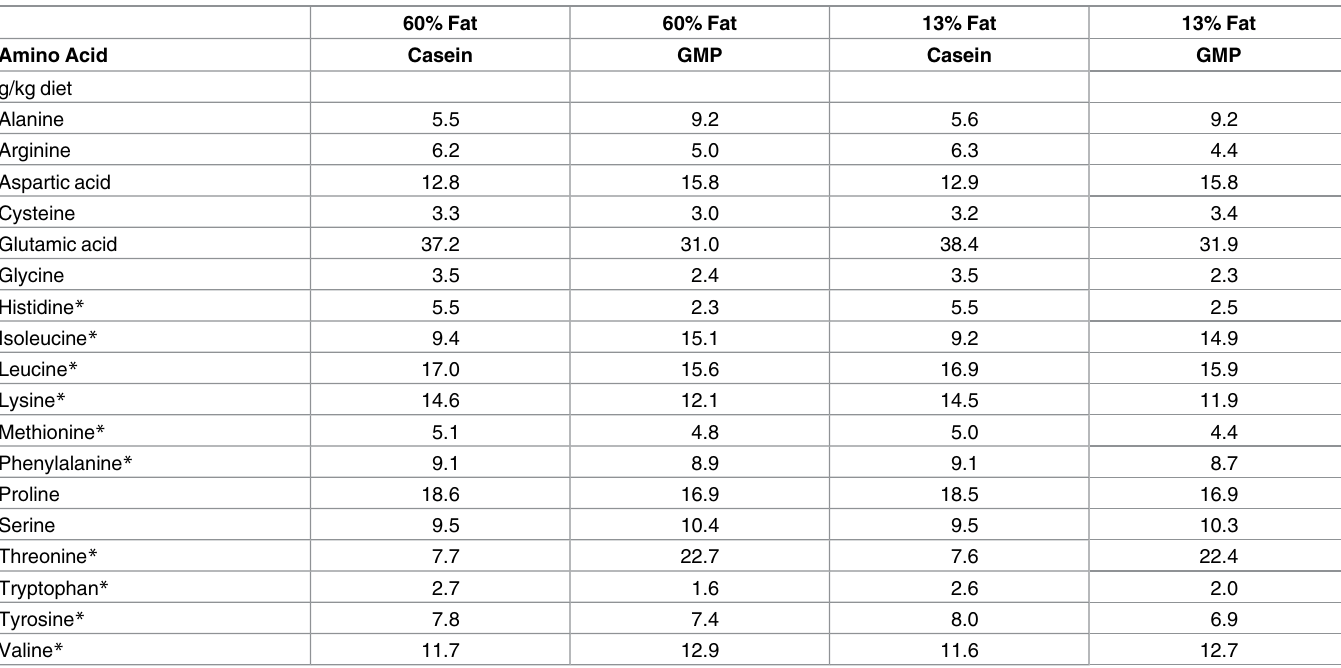
Table 1. Complete amino acid analysis of the